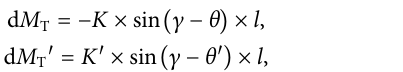
FIGURE 4 | The schematic diagram of the force analysis of the